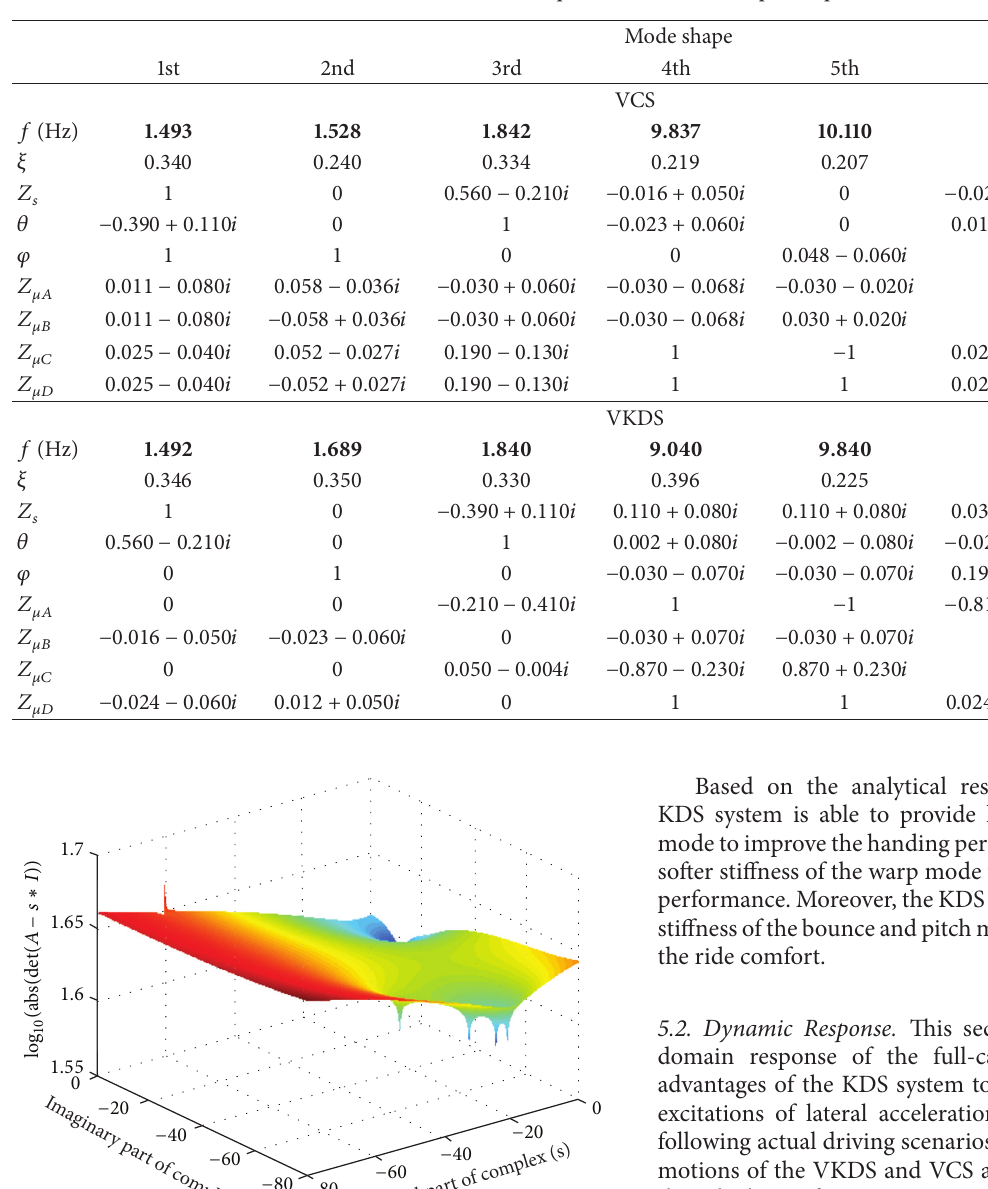
Table 1: Natural frequencies and mode shape comparison.